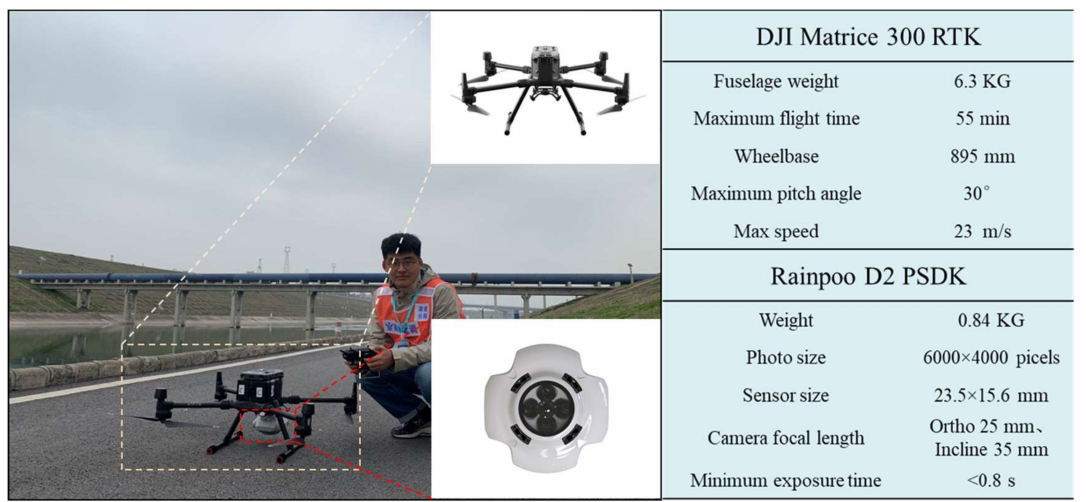
Figure 9. UAV survey site and main equipment specifications.